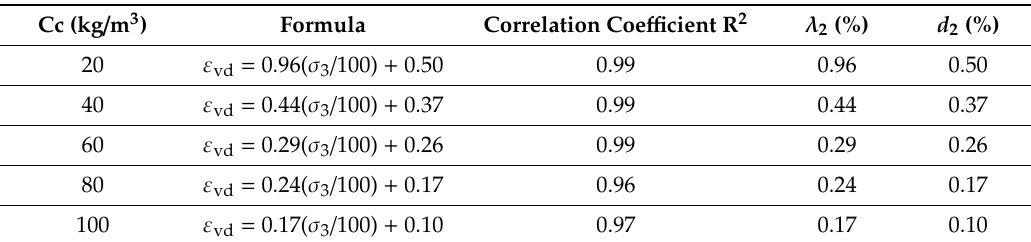
Figure 13. The relationship between the peak volumetric strain ε vd and confining pressure σ 3 . Table 8. Values of R 2 , λ 2 , and d 2